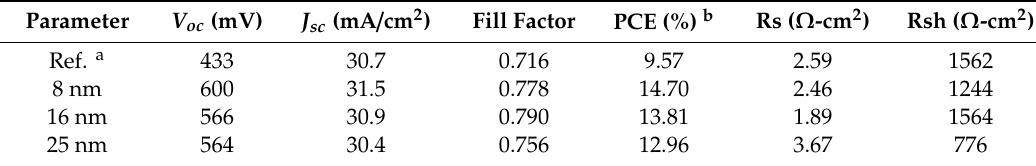
Table 1. Photovoltaic characteristics of the TiO x / Si heterojunction SOLAR CELLS.